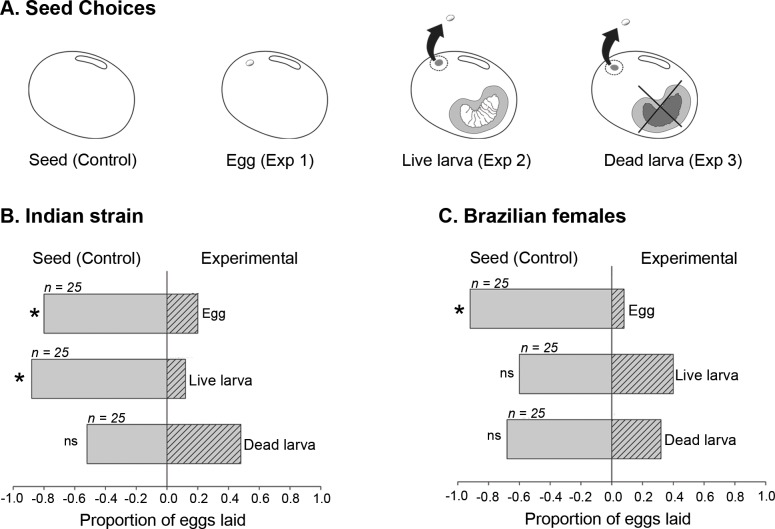
Dichotomous choice trials for Callosobruchus maculatus females (Indian and Brazilian strains) selecting seeds for oviposition.(A) Illustrations of the four seed conditions: Seed alone (Control), and three experimental conditions: Exp 1 seed has an egg laid by another female, Exp 2 has a living larva inside, with visual and chemical cues from the egg surface removed; Exp 3 is the same as for Exp 2 except the larva inside has been killed. (B, C) Results showing the proportion of trials where females chose the experimental condition over the control for the Indian and Brazilian strains respectively. The Indian strain avoids choosing a seed with a live larva even when external markers have been removed. Asterisks indicate significant departure from random expectation based on the adjusted G test (P < 0.05).